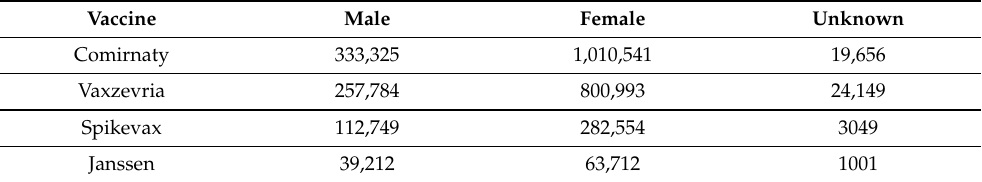
Table 11. Comparative analysis of vaccines by sex.